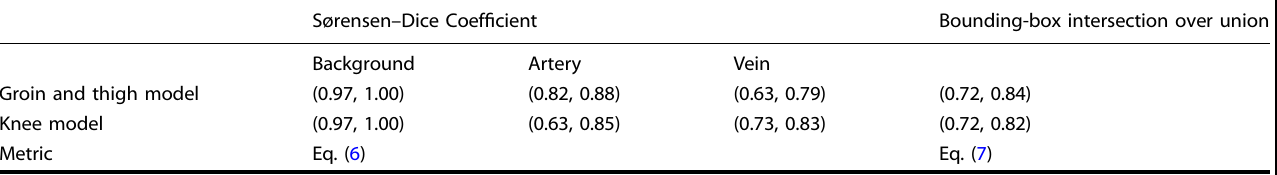
Table 4. Quantitative results for the vessel segmentation task of the used